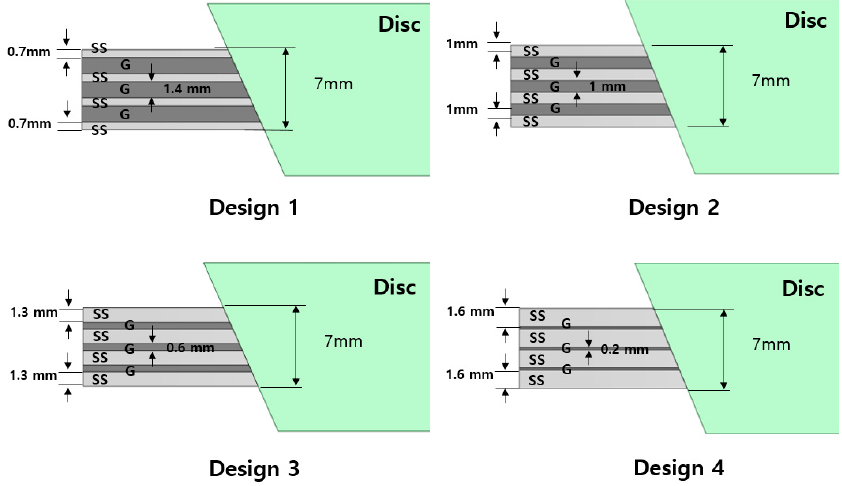
Table 5. The results of the optimization. Figure 20. The geometries of the seven-layers model with different thicknesses of SS and G.